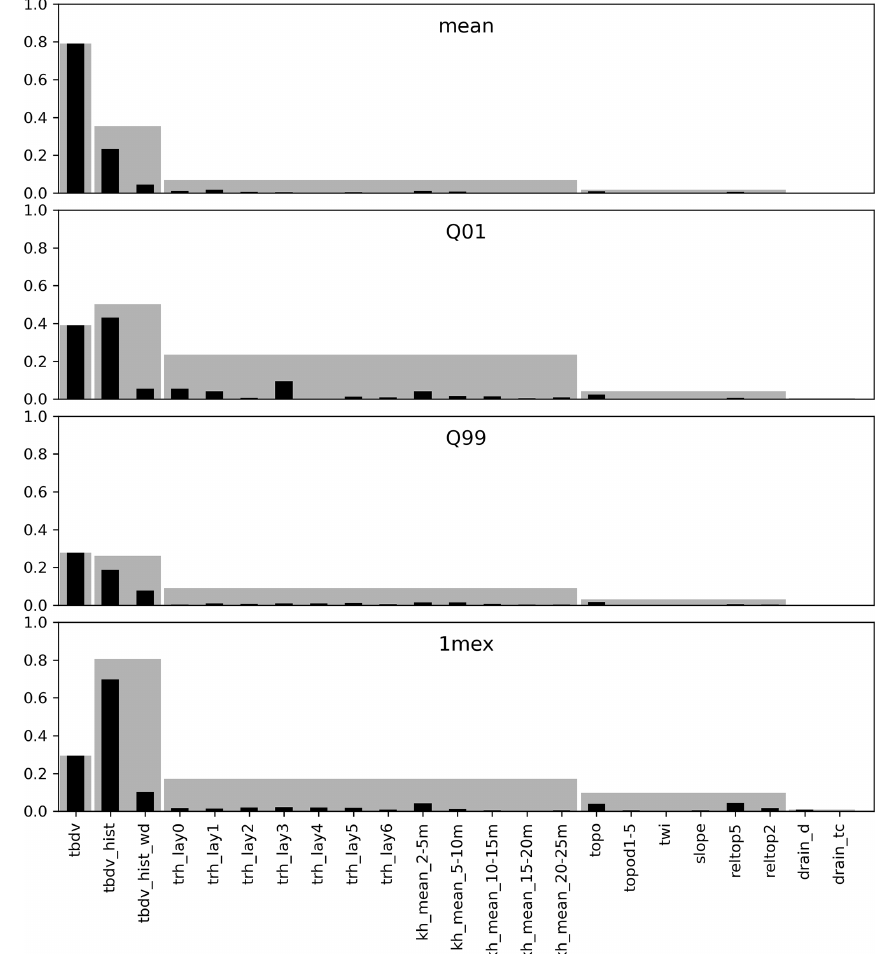
Figure 4. Permutation covariate importance for the four RF downscaling regressors, for each covariate (see Table 3 for an overview). The higher the reduction in R 2 , the higher the importance of the covariate. Each importance is provided permuting one covariate at a time (black bars), and permuting whole groups of covariates (grey